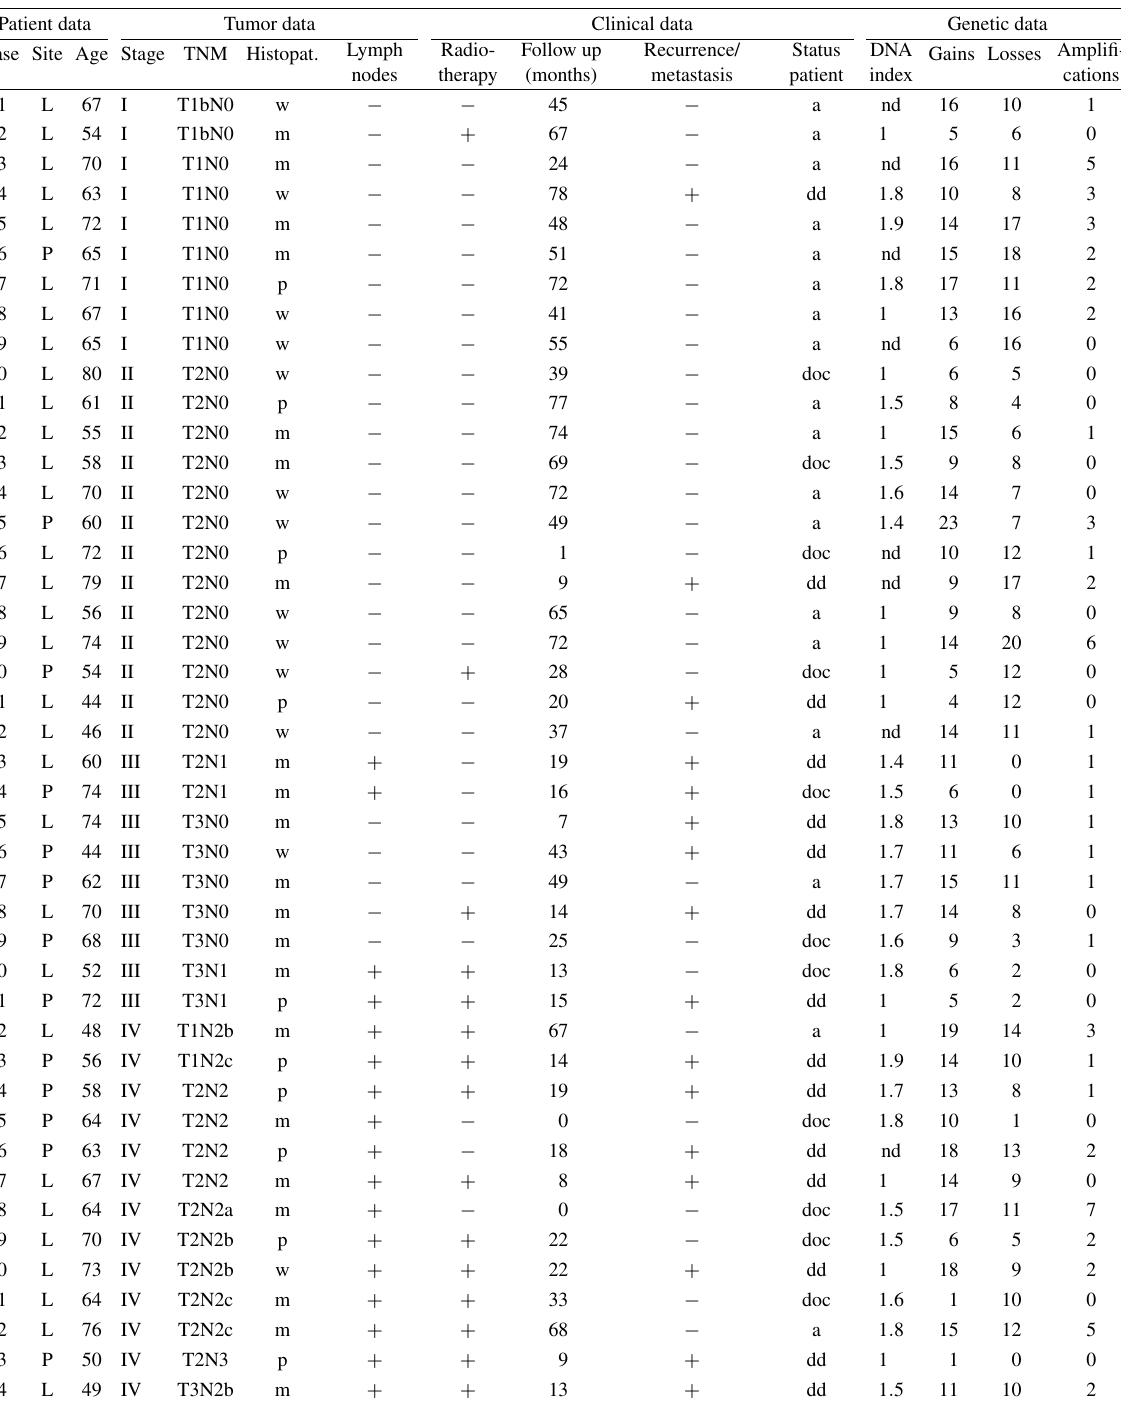
Clinicopathological features, clinical outcome and CGH results of all 56